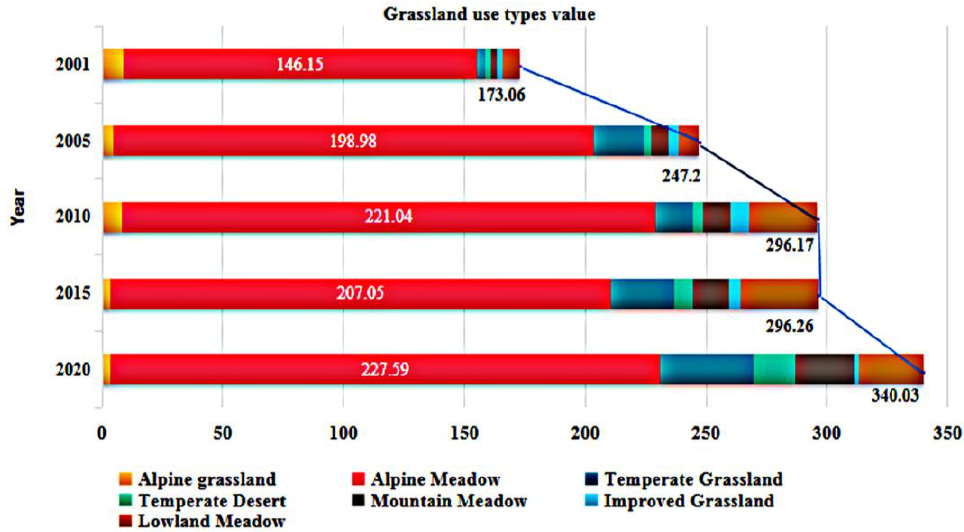
Figure 5. Water conservation function values of different grassland types (USD × 10 8 ).